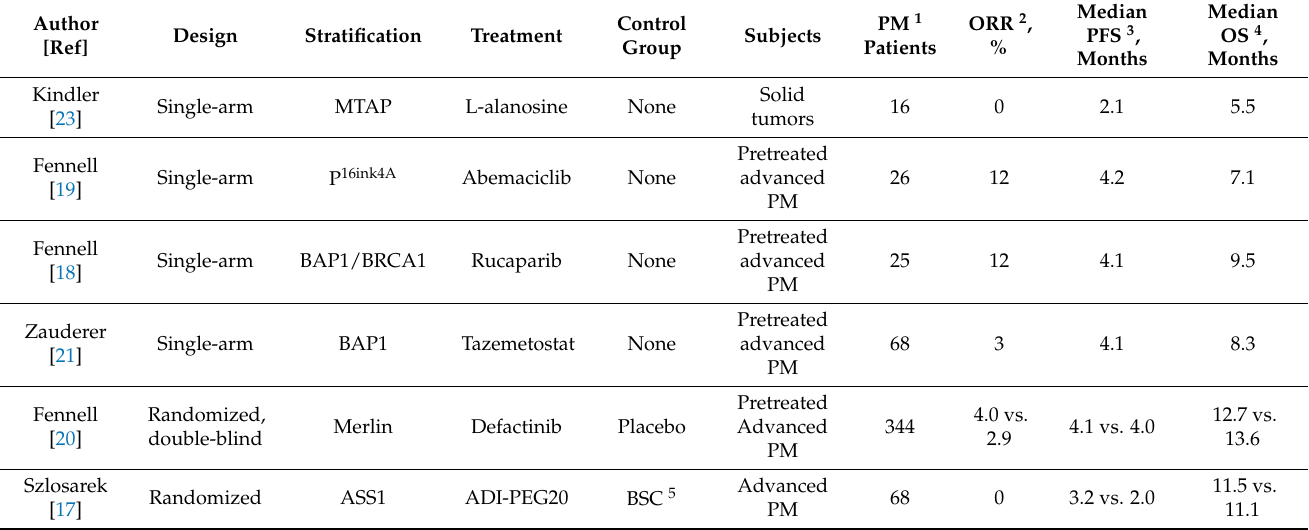
Table 2. Key clinical phase II trials using genetic stratification in pleural